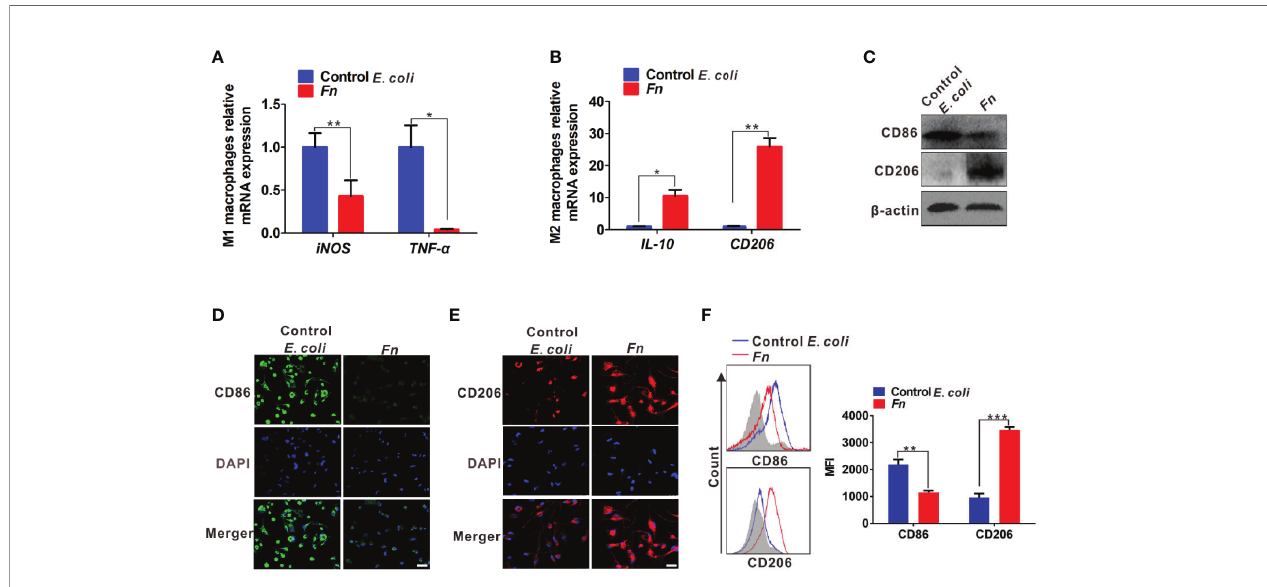
FIGURE 1 | Fn promotes M2-like polarization of M j in vitro . (A, B) qPCR analysis for mRNA levels of M1 markers (iNOS and TNF- a ) and M2 markers (IL-10 and CD206) in M j co-cultured with control E. coli i or Fn for 24 h. (C) Western blot analysis of M1 marker (CD86) and M2 marker (CD206) expression in M j co-cultured with control E. coli or Fn for 48 h. (D, E) Representative immuno fl uorescence images of CD86 + and CD206 + M j after treatment with control E. coli or Fn for 48 h. CD86 was stained with Alexa Fluor 488 (green), CD206 was stained with Cy3 (red). Scale bars: 50 µm. (F) Flow cytometry analysis was performed to detect CD86 + and CD206 + M j after treatment with control E. coli or Fn for 48 h. A statistical mean fl uorescence intensity (MFI) for CD86 + and CD206 + M j is shown in the right panel. Data were expressed as means ± SD in three independent experiments. *p < 0.05, **p < 0.01, ***p < 0.001.